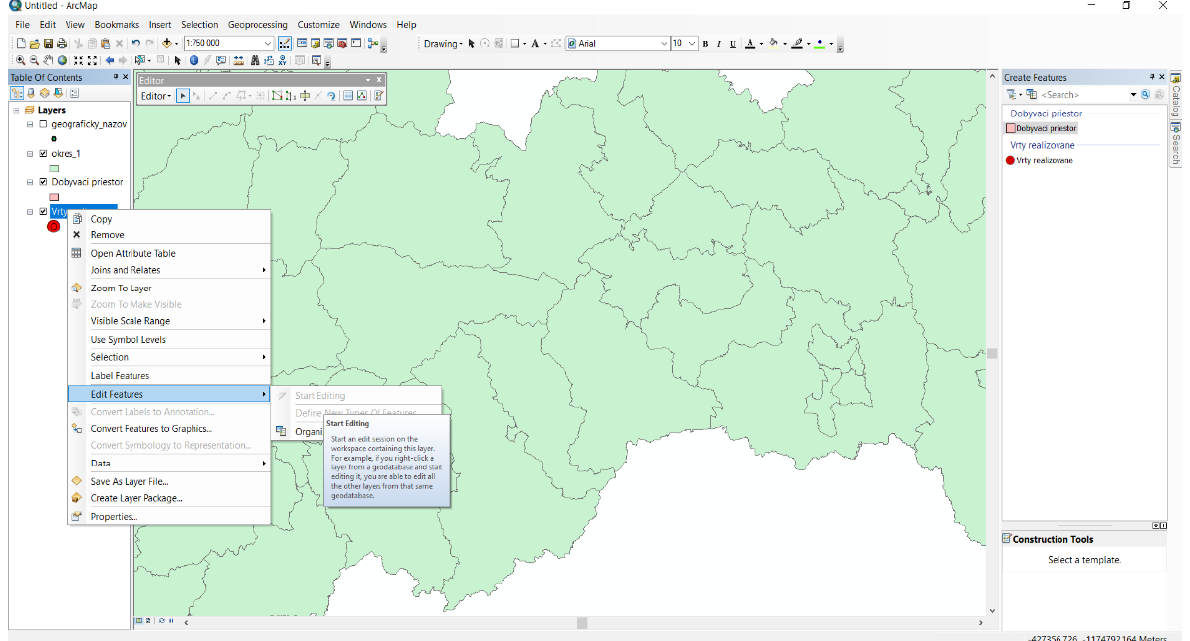
10 of 16 Figure 4. Inserting geographical districts and names, (source: elaborated by authors). The second step was to download and insert the geographical names in the “ .shp ” format (Figure 4 from the source geoportal.sk).